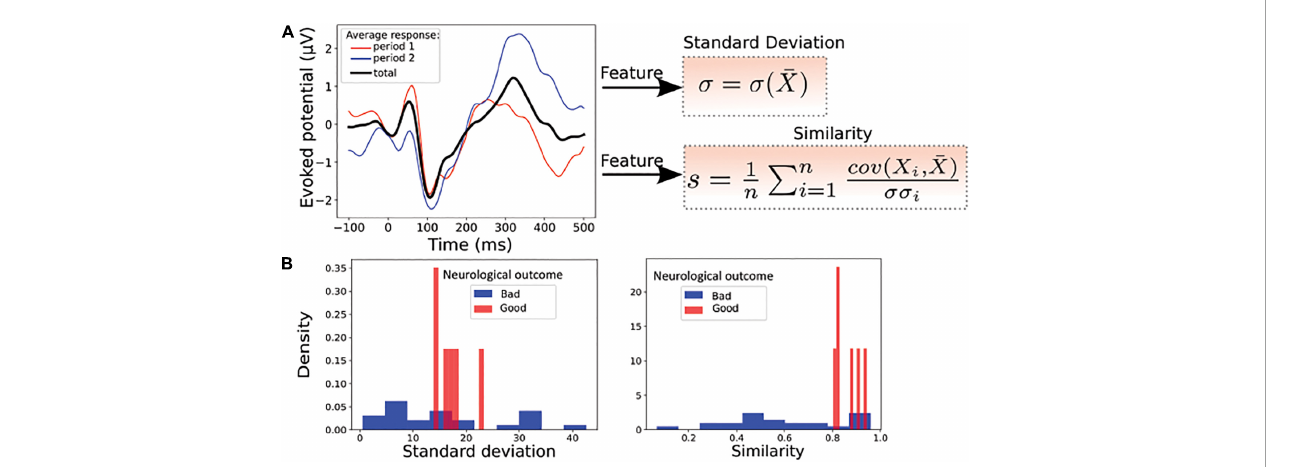
FIGURE2 Statistical features associated to standard responses. (A) Left: average evoked responses computed over a time window of (cid:2) 0 − 10 (cid:3) min (period 1, red), (cid:2) 10 − 20 (cid:3) min (period 2, blue) and over the entire period ( (cid:2) 0 − 20 (cid:3) min , black). Right: the standard deviation σ and the average correlation function s (similarity), between the response over the entire period ( (cid:2) 0 − 20 (cid:3) min ) and over one of the n periods ( [ 0 − 20 ] min or (cid:2) 10 − 20 (cid:3) min ), here n = 2. (B) Example of features distribution of dataset from the Cz electrode: standard deviation (Left) and similarity (Right) computed over the entire period; red (good neurological outcome) and blue (bad neurological outcome). These two parameters taken separately are insufficient to properly discriminate the two groups of patients.